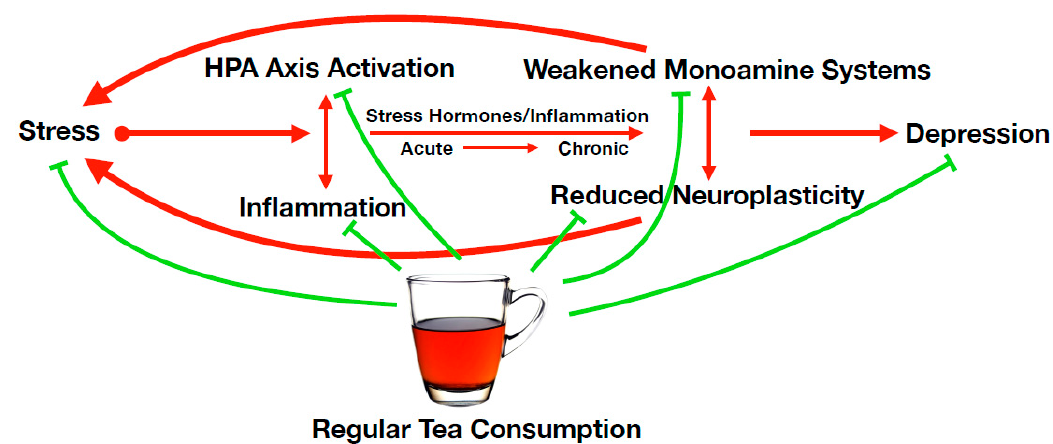
Figure 1. The effects of regular tea intake within a unified theory of depression pathology. External